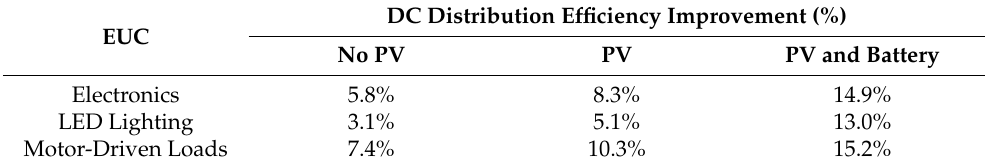
Table 4. DC distribution efficiency improvement by EUC and system